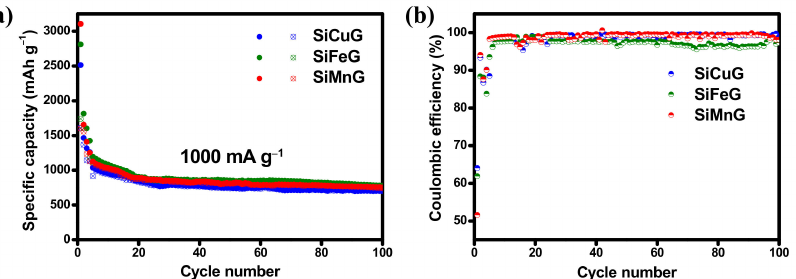
Figure 11. ( a , b ) Cyclability and respective Coulombic efficiency results of SiCuG, SiFeG, and SiMnG vs. Li/Li + as counter electrode with 1 M LiPF 6 in EC:DEC:FEC ( v / v ratio of 5:70:25) electrolyte at 1000 mA g − 1 in the potential window of 0.01–2.0